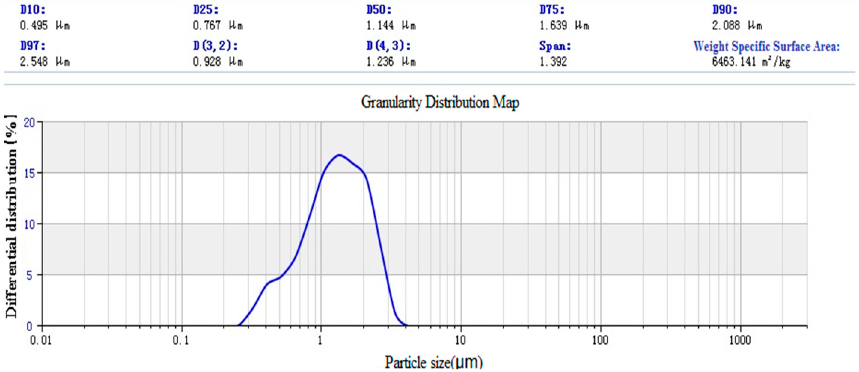
Figure 14. Laser particle size analysis of nano-silica.